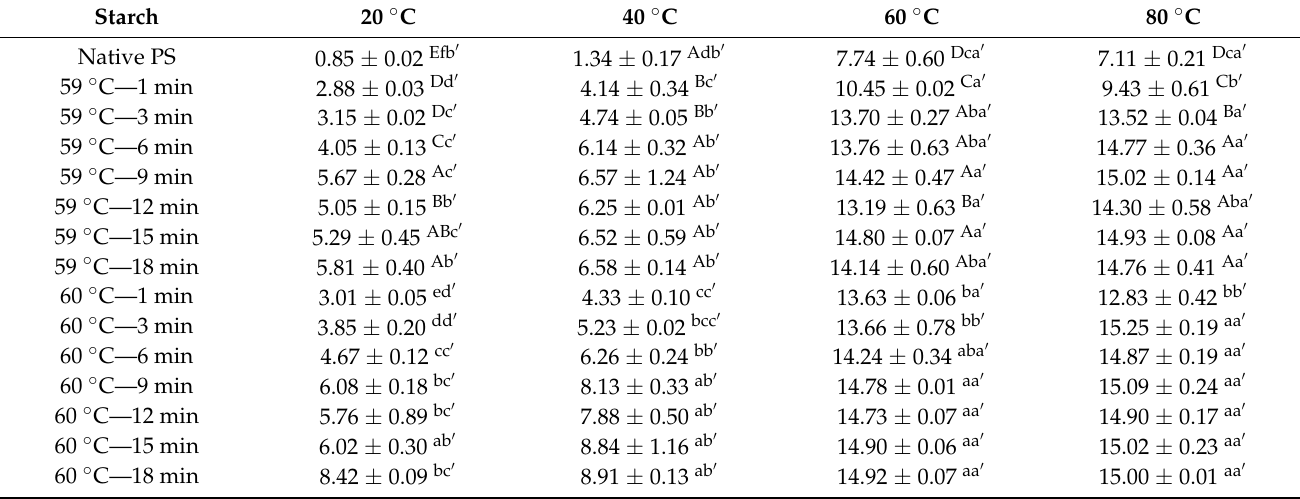
Table 2. The WBC of native and partially gelatinized starch samples (10 − 2